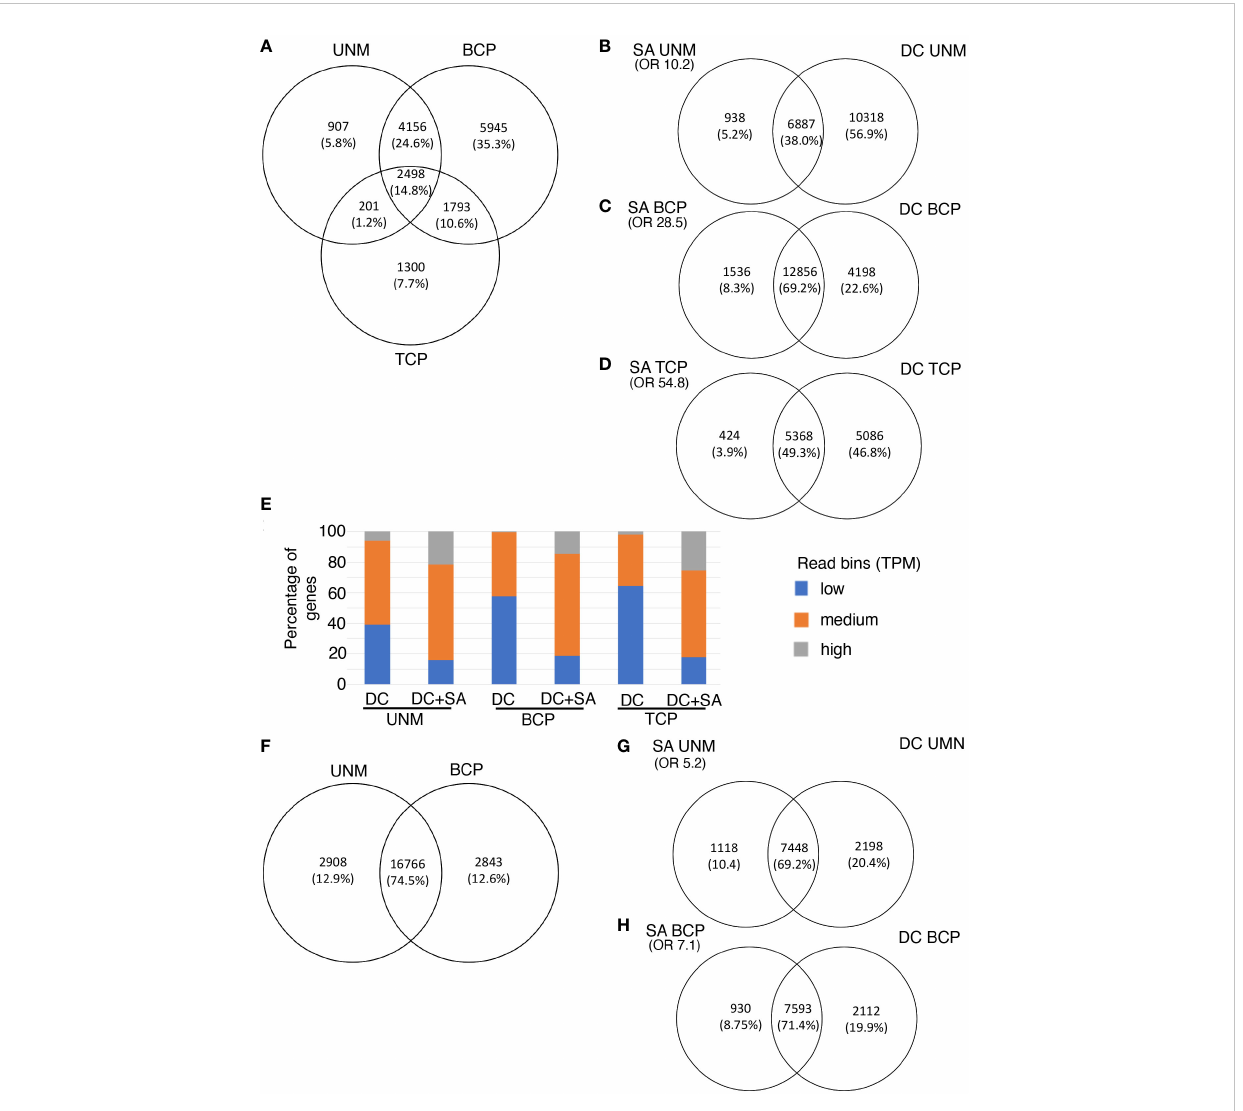
FIGURE 3 Single anther RNA-Seq for Arabiopsis (A – E) and kiwifruit (F – H) . (A – E) Genes expressed in three stages of pollen development from Arabidopsis (A) Venn diagram showing the number of genes and overlap of genes detected by the single anther (SA) RNA-Seq method at three developmental stages. (B – D) Overlap of genes at each stage of Arabidopsis pollen development as detected by SA RNA-Seq and density centrifugation (DC) RNA- seq protocols. (E) Expression level of genes detected only in the DC data (right panels B to D) or expressed in both the DC and the SC datasets (DC + SA; overlap panels B to D) at each stage of pollen development in Arabidopsis. Genes have been split into expression bins of low (0-10 TPM), medium (10-100 TPM) or high (>100 TPM). (F – H) Two stages of pollen development from kiwifruit. (F) Venn diagram showing the number of genes and overlap of genes detected by the single anther (SA) RNA-Seq method for kiwifruit. (G, H) Overlap of genes at each stage of development as detected by kiwifruit SA RNA-Seq and density centrifugation (DC) RNA-seq protocols. Only genes with reciprocal blast hits (RBHs) between the Arabidopsis and kiwifruit genomes are included. OR, Odds Ratio as determined by the Fisher ’ s exact test. An OR close to 1 represents means no association between two lists and the higher the value the stronger the association. UNM, uninucleate microspores; BCP, bicellular pollen; TCP, tricellular